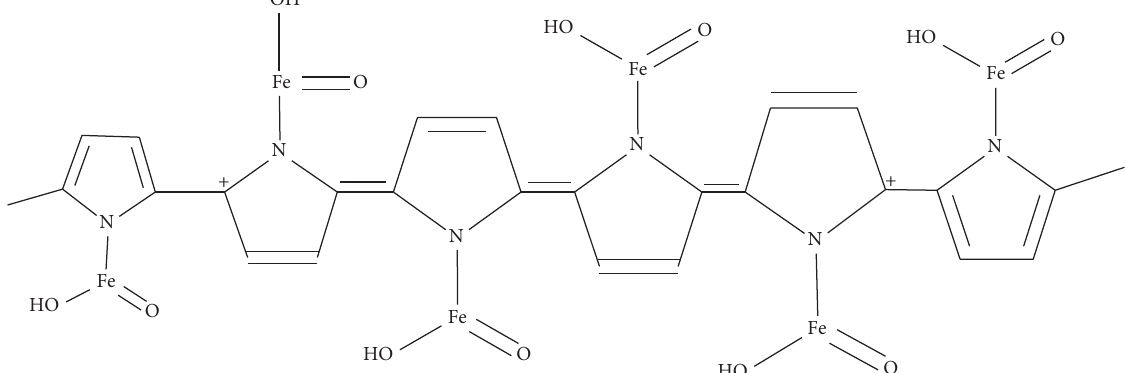
Figure 6: Suggested schematic diagram of PFFs nanocomposite in the detection of